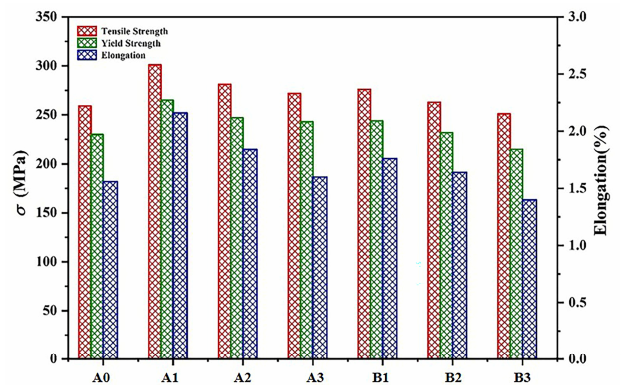
Figure 6. Strength and elongation of as-cast Al-9.5Si-1.5Cu-0.8Mn-0.6Mg alloy.